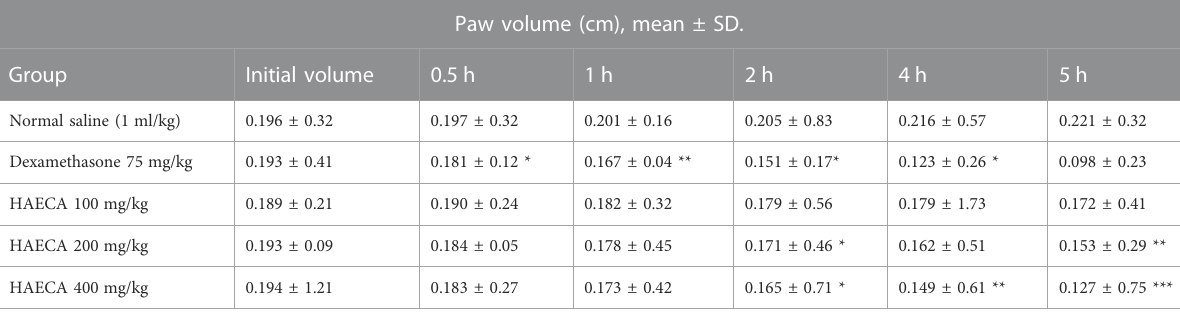
Paw volume (cm), mean ±